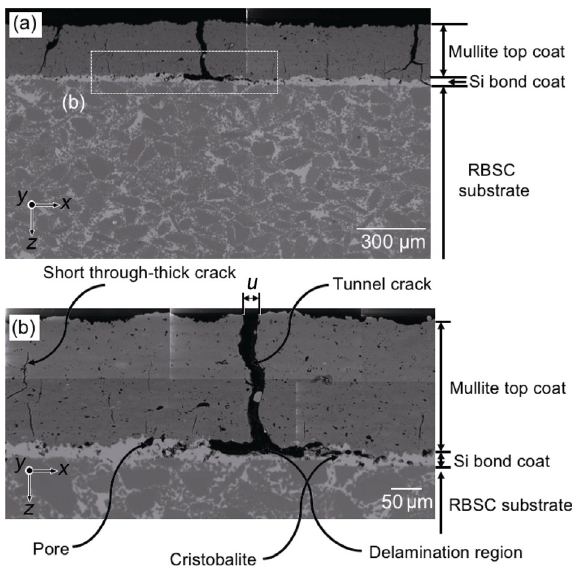
Fig. 4 Example of X-ray CT image after cracking and partial delamination: (a) xy -plane, (b) xz -plane between line A and B in (a).